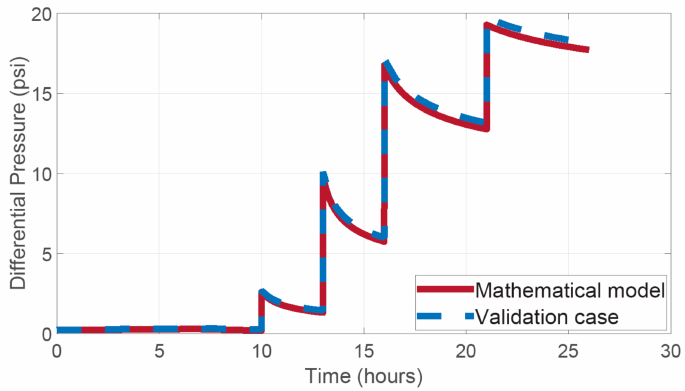
Figure 7. Differential pressure